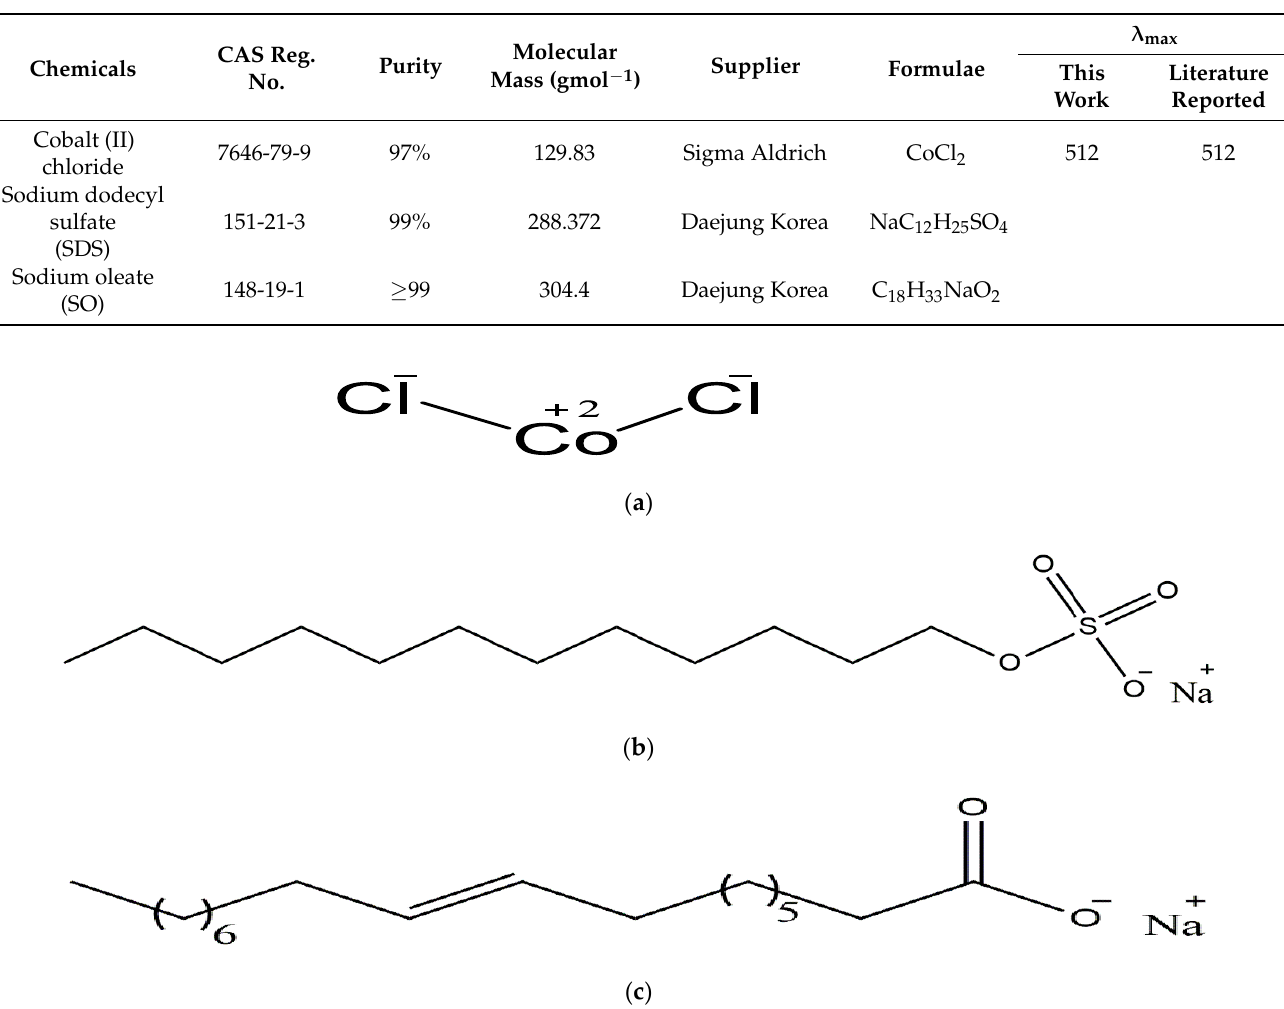
Table 7. Purity, supplier, CAS registry number, and maximum wavelength of chemicals used.